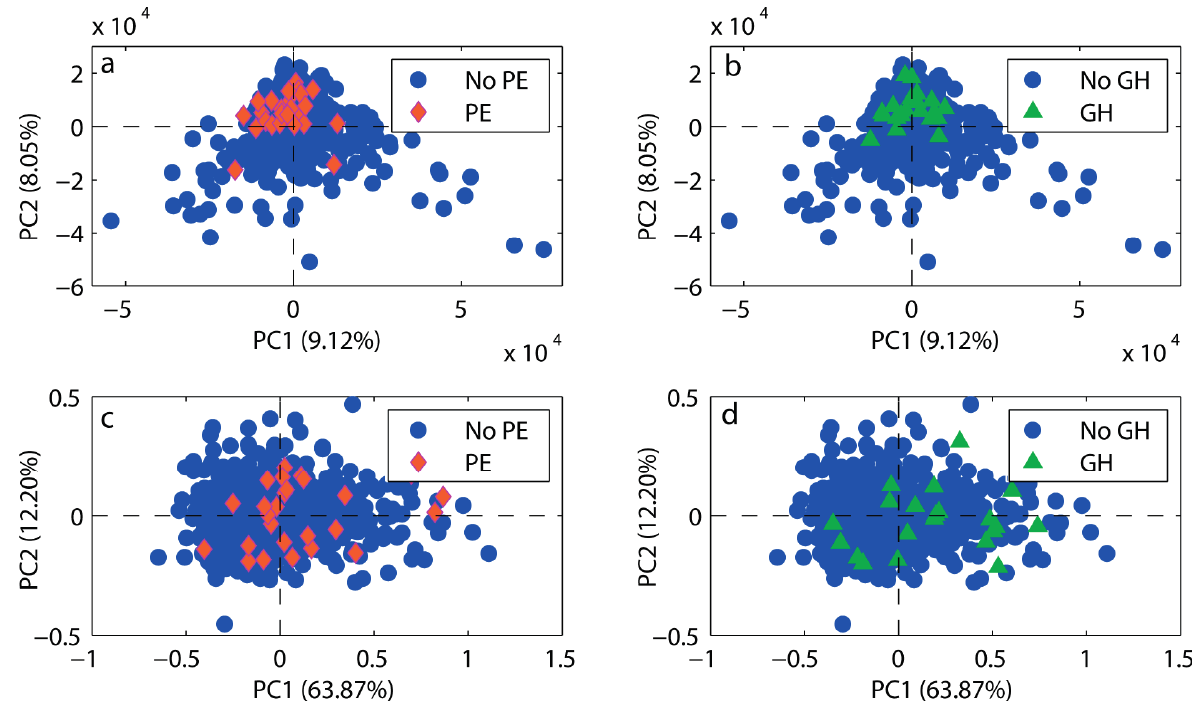
Figure 1. Score plots from principal component analysis (PCA) of urine and serum spectra. PCA score plots of the first and second principal components (PCs) with the percent variance explained, performed on urine samples ( a , b ) and serum samples ( c , d ). Urine samples gave a clustering of women set to develop preeclampsia (PE) (red diamonds, n = 26) or gestational hypertension (GH) (green triangles, n = 21), while serum samples gave no apparent clustering. Samples from women without hypertensive disorders of pregnancy are shown in blue circles n =